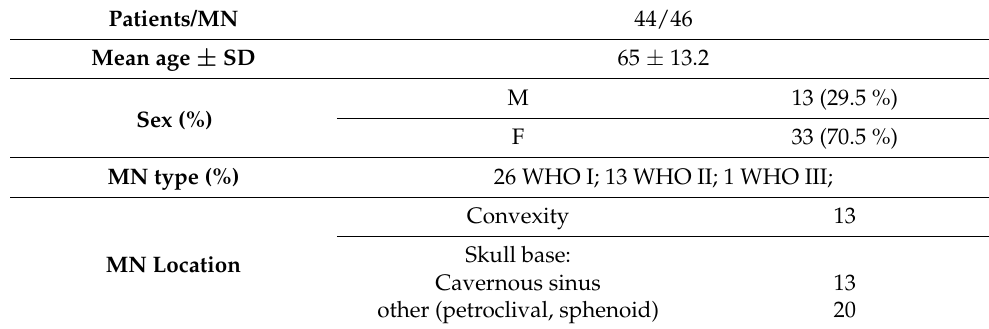
Table 1. Demographic characteristics and conventional MRI features of patient